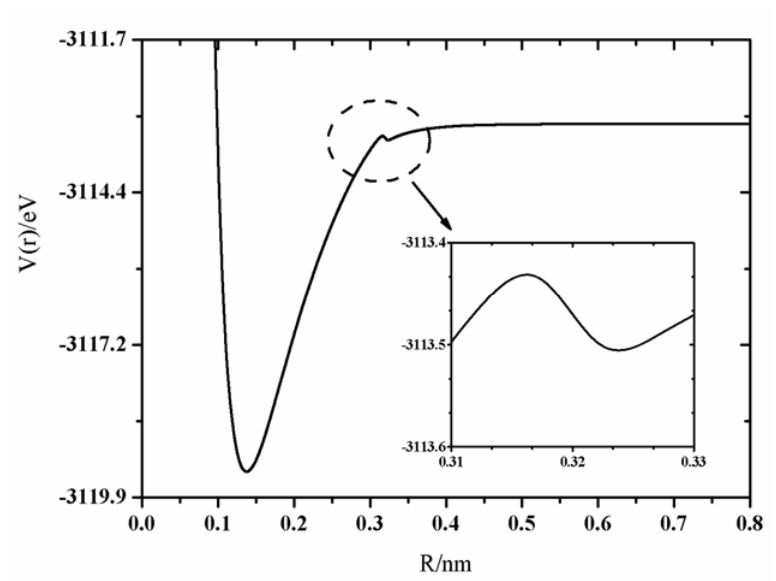
Figure 2. PEC of the X 2 Σ +